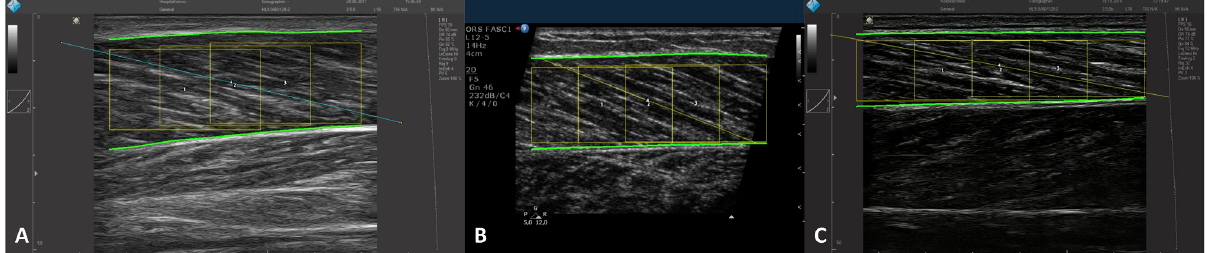
Fig 7. Examples of processed scans from Samples A, B and C, with overlay of composite fascicles and regions of interest used in the analysis.